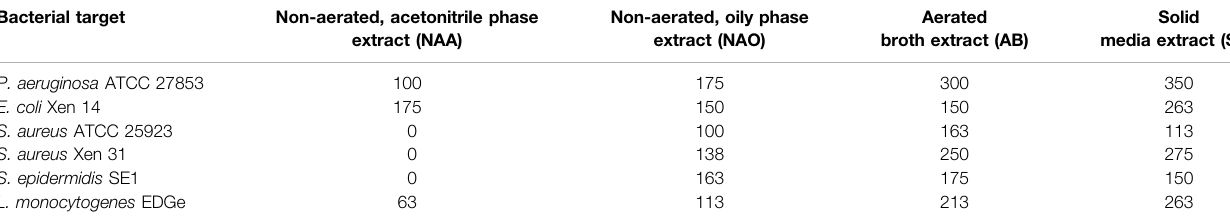
Activity is indicated by clear zone area (mm 2 /mg) in the agar well diffusion